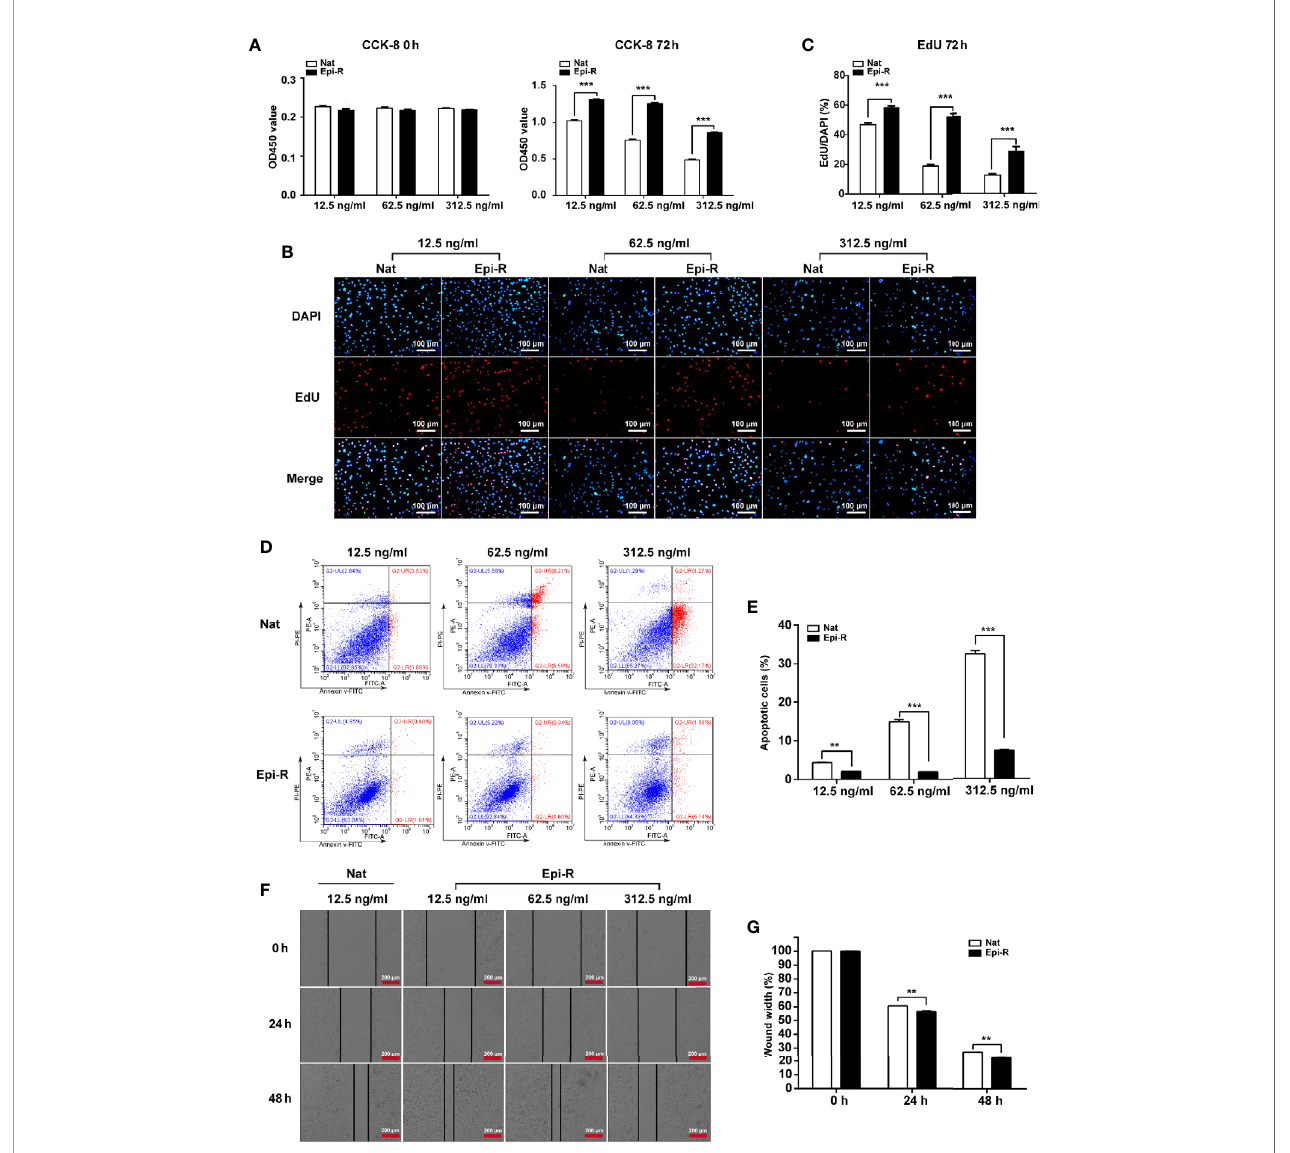
FIGURE 1 | Characterization of epirubicin-resistant MDA-MB-231 cells. Epirubicin-resistant (Epi-R) and native (Nat) MDA-MB-231 cells were exposed to different concentrations of epirubicin (12.5 ng/ml, 62.5 ng/ml and 312.5 ng/ml). (A) Cell proliferation analysis by CCK-8 assay. (B) Cell proliferation analysis by EdU assay. DAPI for nuclei. Scale bars: 100 m m. (C) Quantitative analysis of EdU assay. (D) Flow cytometry analysis of cell apoptosis. (E) Quantitative analysis of apoptotic cell percentages. (F) Cell migration analysis by wound healing assay. Scale bars: 200 m m. (G) Quantitative analysis of cell migration. n = 3. Data are represented as the mean ± SD, ** P < 0.01, *** P <